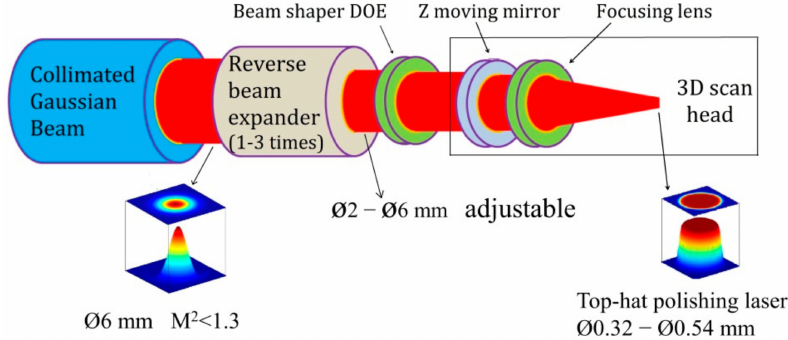
Figure 1. Combination of CW laser expander and